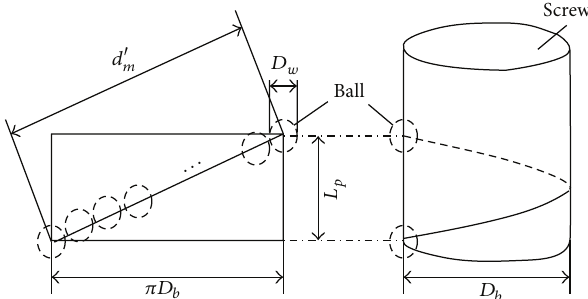
Figure 4: Effective pitch diameter and number of balls of ball-screw when considering it a rolling